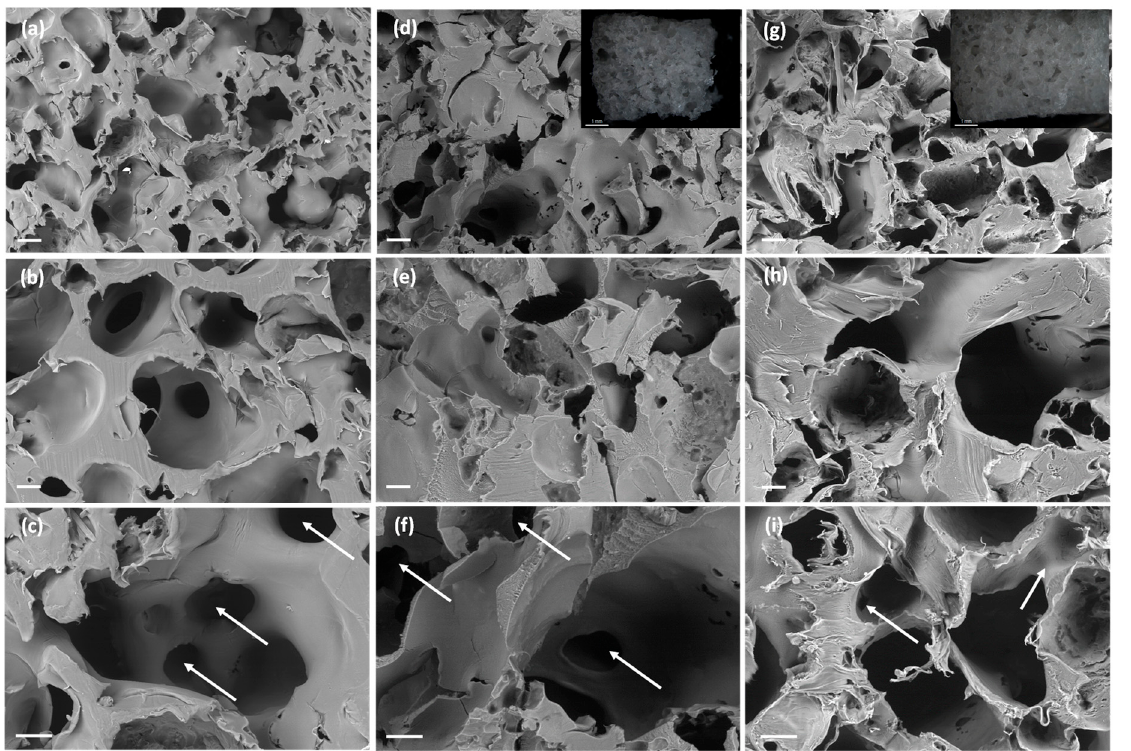
Figure 2. SEM-images of cross sections of ( a – c ) PCL(0K)50BA, ( d – f ) PCL(5K)50BA, and ( g – i ) PCL(10K)50BA polymeric scaffolds loaded with 0, 5, and 10 wt.% of ketoprofen, respectively. Insets in ( d , g ): Optical micrographs of the scaffolds. The presence of interconnected pores was observed for all the formulations (white arrows in c , f , and i ). Scale bars: ( a , d , g ) 200 µm; ( b , c , e , f , h , i ) 100 µm; (insets) 1 mm.